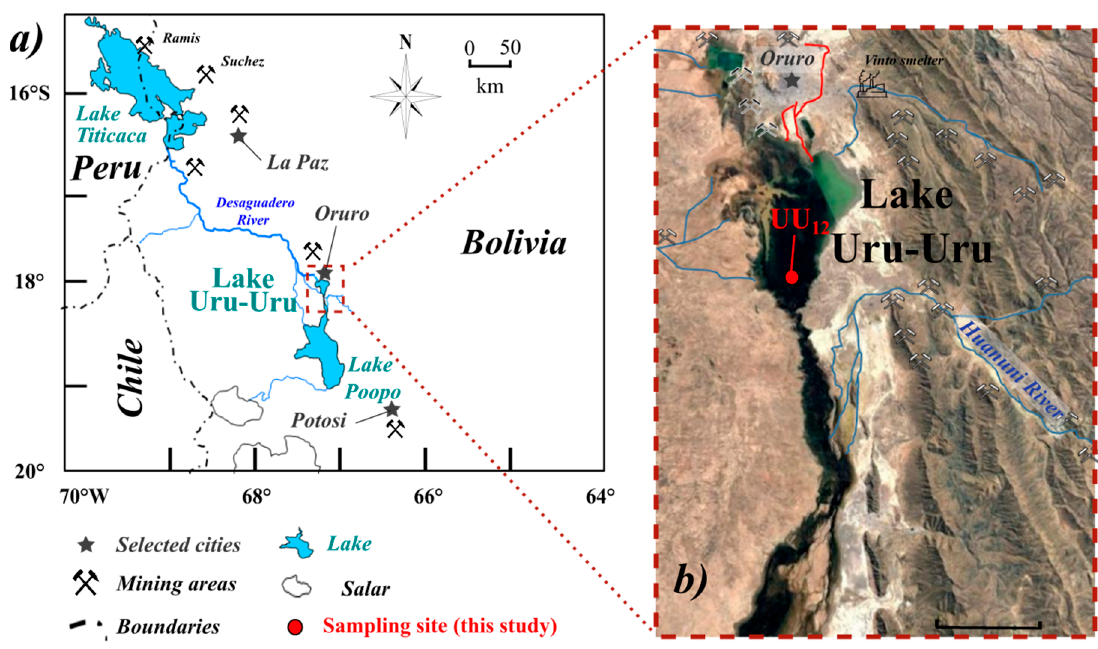
Figure 1. ( a ) Study site location: location of Lake Uru Uru in the Bolivian Altiplano and ( b ) sampling site (UU 12 ) in the southern part of the lake.